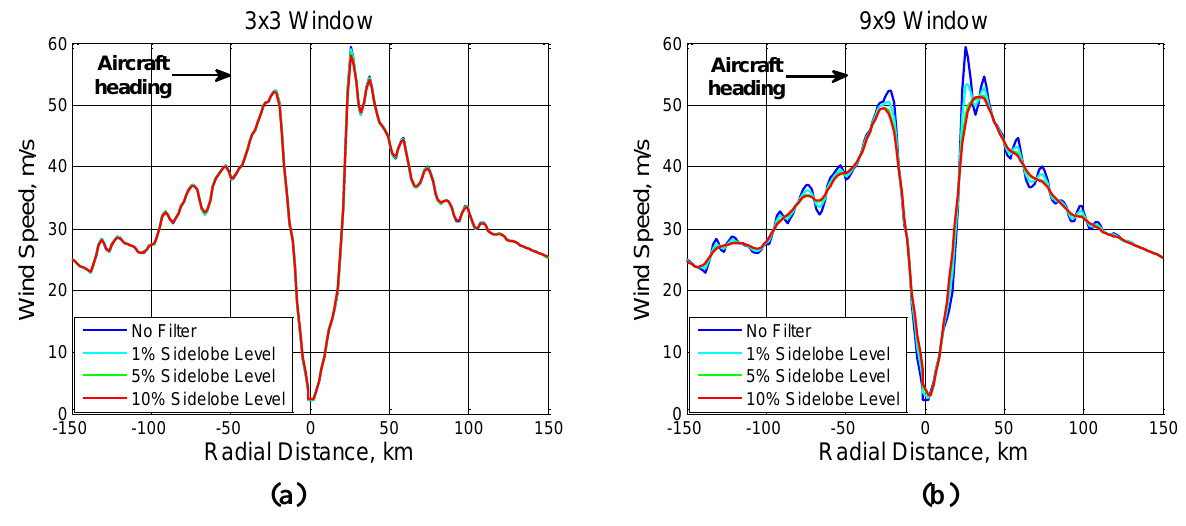
Figure 3. The ground track wind speed for: (a) 3 × 3 and (b) 9 × 9 ―top hat‖ filter windows for different sidelobe levels (shown in different colors) and the unfiltered wind (blue).